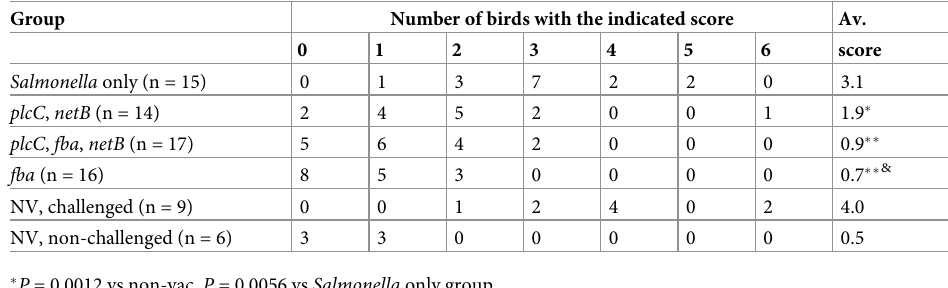
Table 4. Intestinal lesion scores from Experiment 3. Group Number of birds with the indicated